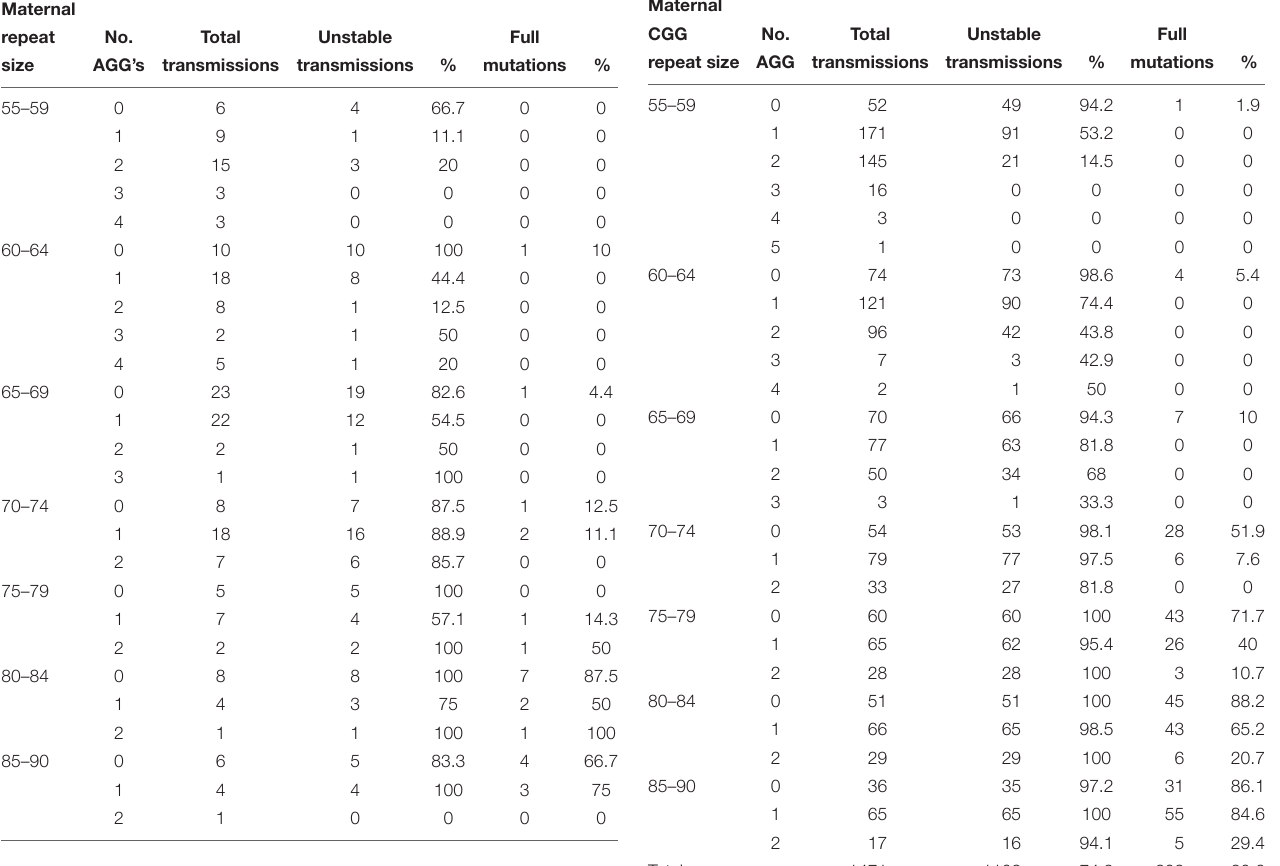
TABLE 3 | Unstable transmissions and full mutation expansions sorted by repeat size and number of AGGs among Israeli population. Maternal